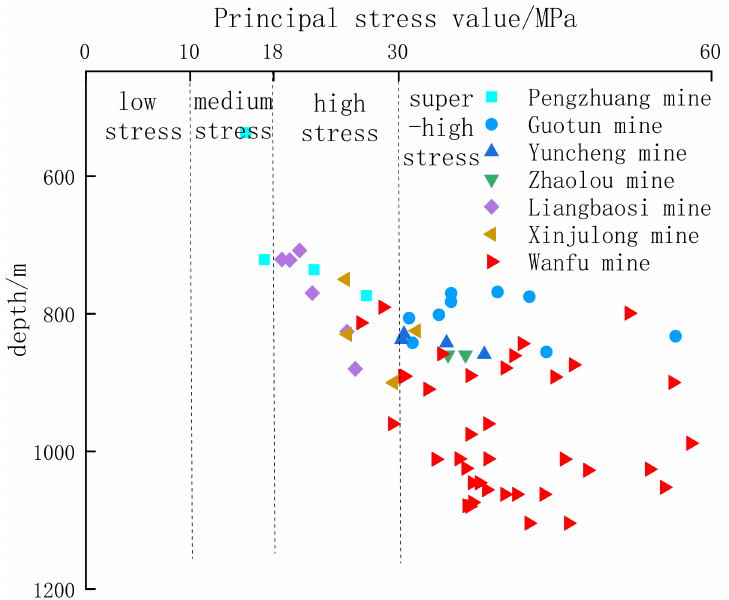
Figure 7. Stress distribution grade of each measurement